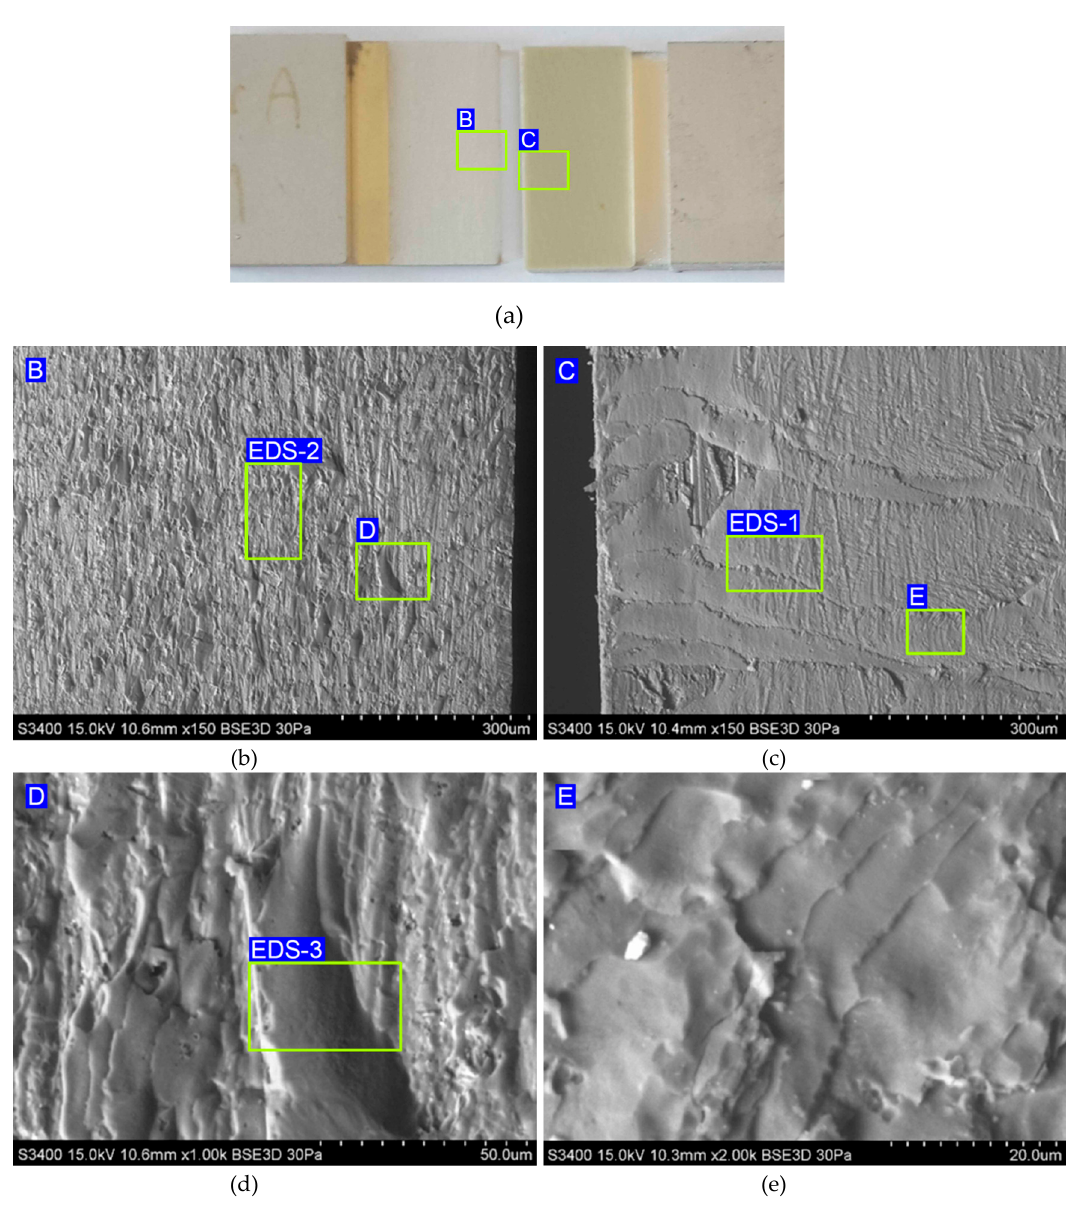
Figure 14. ( a ) Macrograph of the specimen tested at − 60 °C with both sides of the failure and ( b – e ) magnifications of the surface of the fracture.